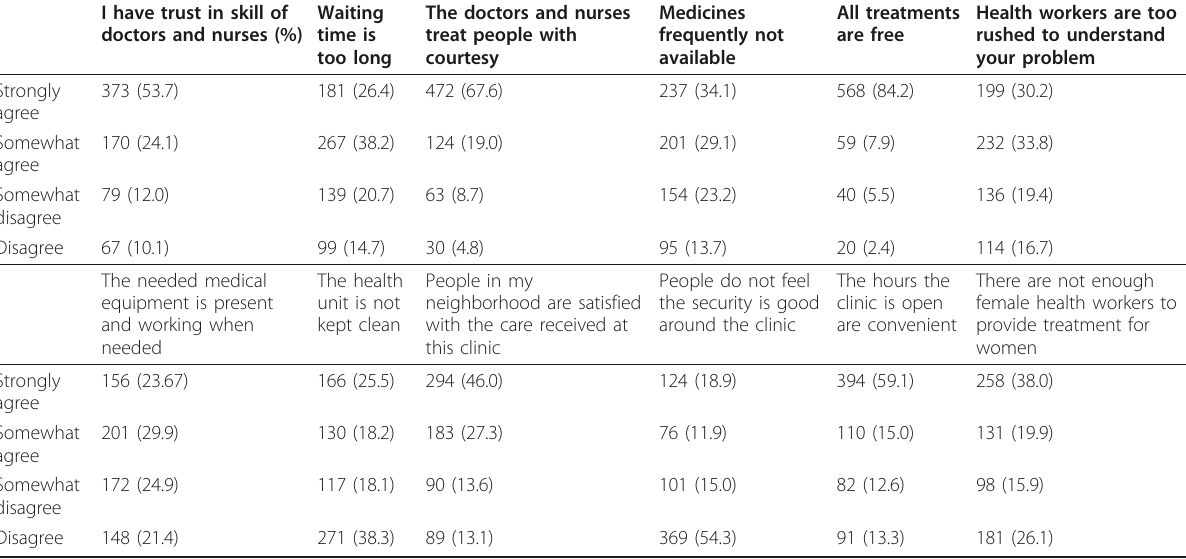
Table 2 Perception of respondents concerning the PHCC nearest to